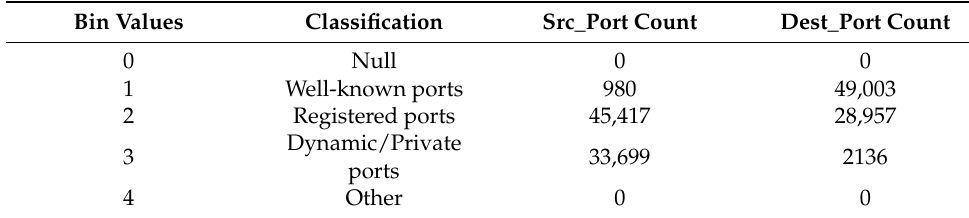
Table 10. Number of unique values before and after binning dest_port and src_port. Bin Values